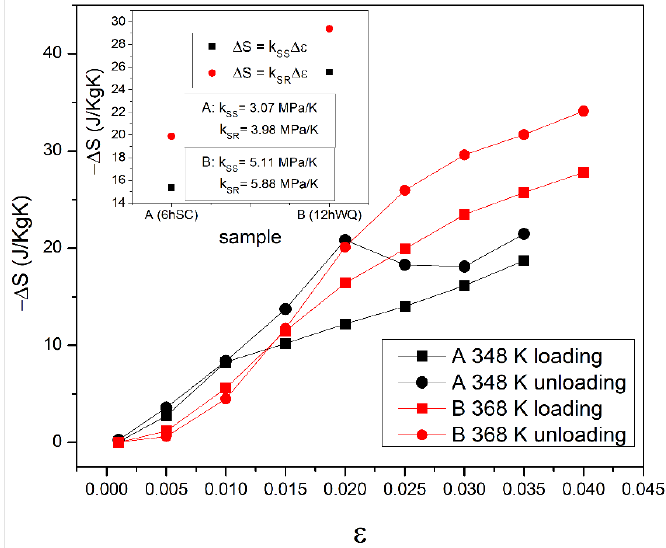
Figure 4. Value for ∆ S vs. strain obtained using discrete integration from stress–strain curves at different temperatures in the loading and unloading stages for samples A and B. Table 1. Registered values for Clausius–Clapeyron coefficient K for samples A and